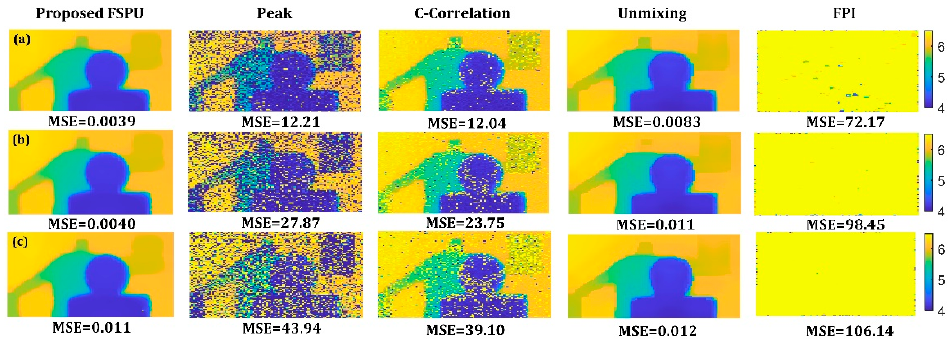
Figure 8. Experimental result. ( a ) Low noise level, 953 ppp for first four methods, 38 ppp for FPI; ( b ) mid noise level, 916 ppp, 21 ppp; ( c ) high noise level, 845 ppp, 13 ppp. 916 ppp, 21 ppp; ( c ) high noise level, 845 ppp, 13